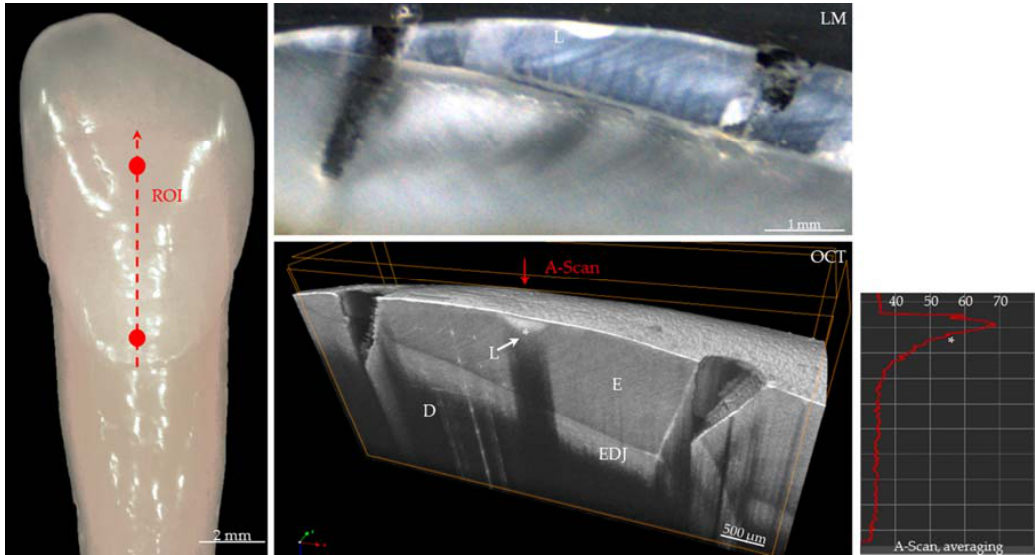
Figure 10. Extracted human canine. There is no conformance of visual assessment with OCT. Visual inspection of the dry smooth surface does not reveal signs of an early ‐ stage carious lesion (L). In contrast, the 3D SD ‐ OCT cross ‐ sectional image of the ROI showed a distinct bright area (L) within the first quarter of enamel (E) with a shadow underneath. The lesion can be confirmed using light microscopy (LM). The A ‐ scan of the position marked in the OCT ‐ image shows the depth profile of the demineralized zone in the enamel surface (A ‐ Scan average 5, additional signal median averaging 6). * grey scale between demineralized and healthy region.